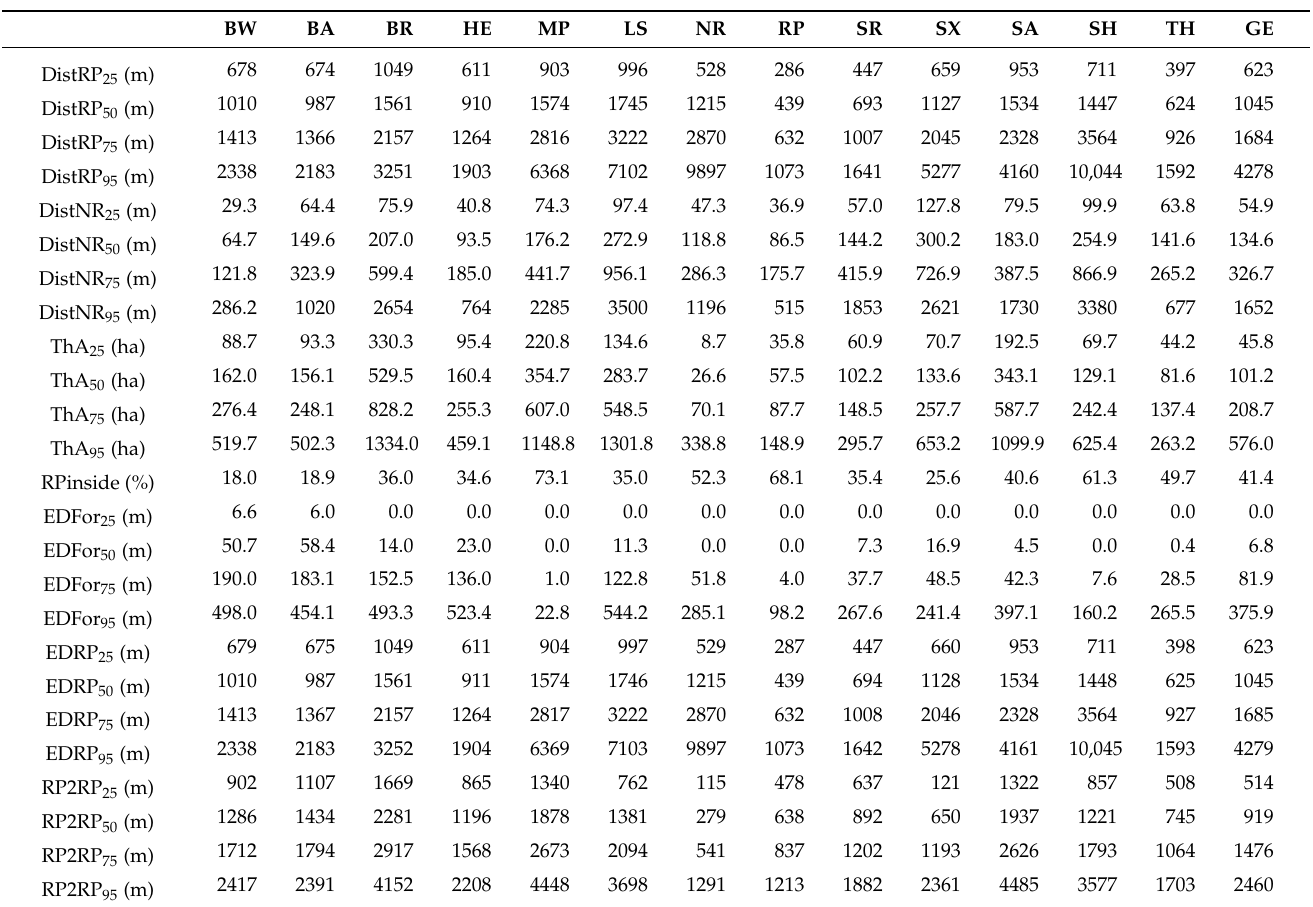
Table 3. Different rescue point data indices of the federal states and the federal level. Indices: DistRP xx (xx- quantile Euclidean distance from a random point to the nearest rescue point), DistNR xx (xx-quantile Euclidean distance from a random point to the nearest NavLog road), ThA xx (xx-quantile of the Thiessen polygon area per rescue point in ha), RPinside (% of the rescue points within the forest area), EDFor xx (xx-quantile of the Euclidean distance from a rescue point to nearest forest in m), EDRP xx (xx-quantile Euclidean distance from a random point to the nearest rescue point), RP2RP xx (xx-quantile Euclidean distance from one rescue point to the next rescue point). Abbr.: Baden- Württemberg (BW), Bavaria (BA), Brandenburg (BR), Hesse (HE), Mecklenburg Western Pomerania (MP), Lower Saxony (LS), North Rhine-Westphalia (NR), Rhineland-Palatinate (RP), Saarland (SR), Saxony (SX), Saxony-Anhalt (SA), Schleswig-Holstein (SH), Thuringia (TH), Germany